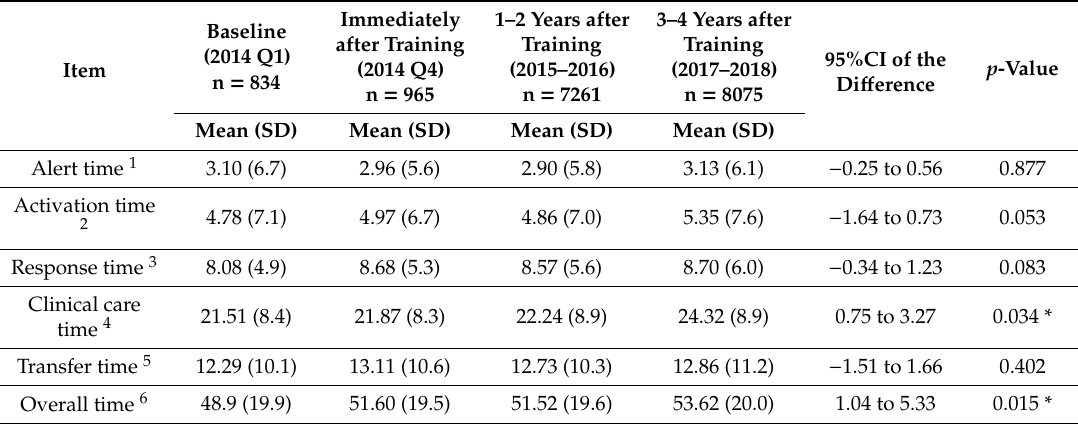
Table 3. Di ff erences in time performance over